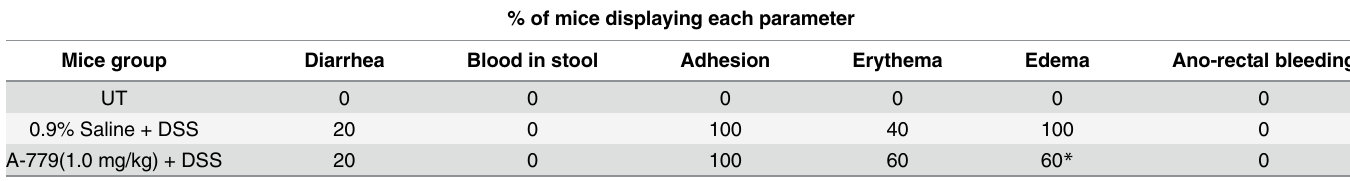
Colitis severity was assessed by macroscopic examination in UT mice, or mice treated with saline or A779 for 4 days along with DSS treatment. Numbers are the means of 5 – 9 mice for each group (9 for UT and 5 for DSS/i.p saline and DSS/A779). * denote signi fi cant difference from DSS/i.p saline treated